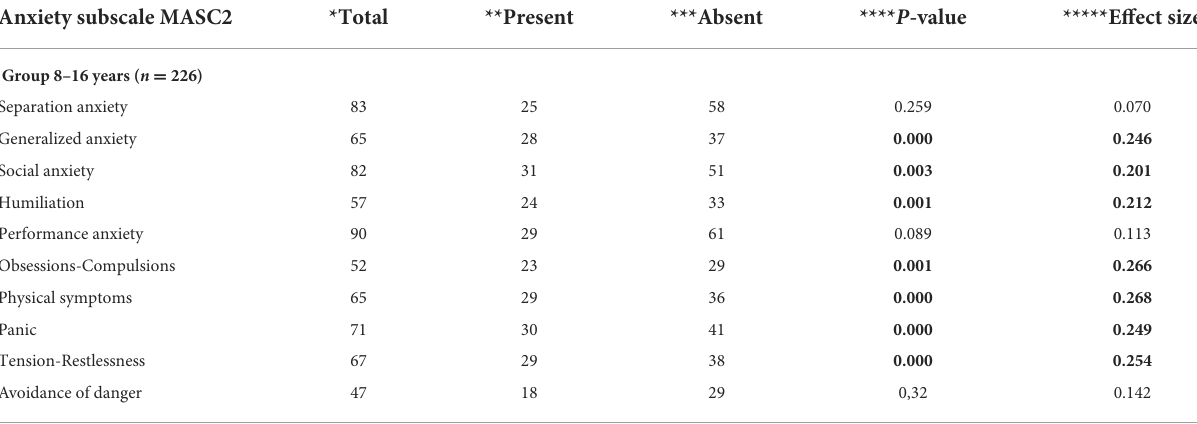
TABLE 4 Comparison between patients who had symptoms at 3–5 months after COVID-19 infection and those who did not. Anxiety subscale MASC2 *Total **Present ***Absent **** P -value *****Effect size